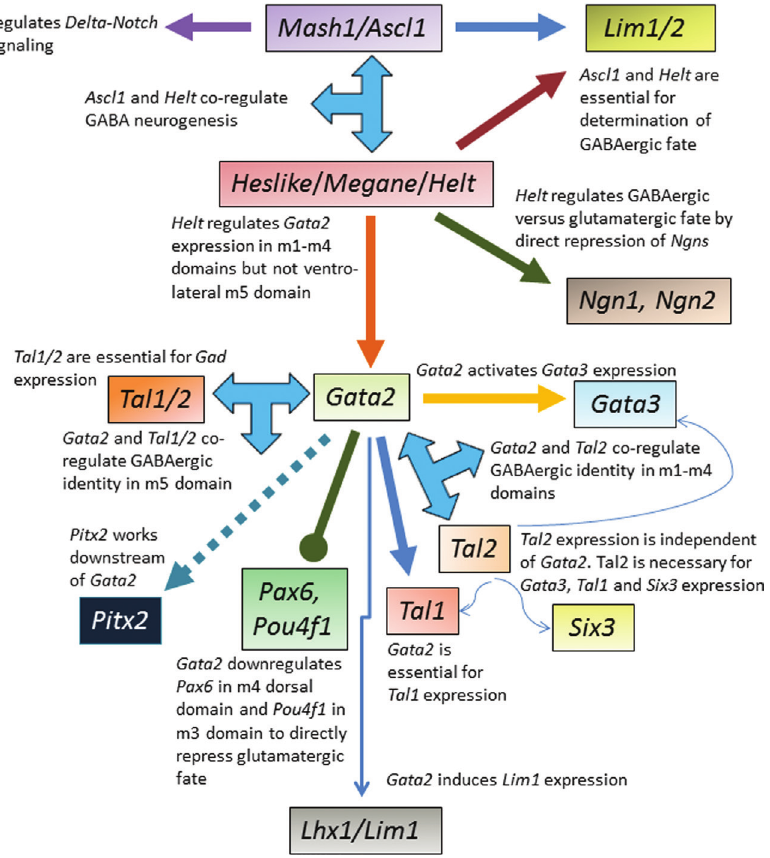
Figure 3 Summary of the signaling pathway of key molecular players identified up until now and their interplay that is essential for effi- cient generation of mesencephalic GABA